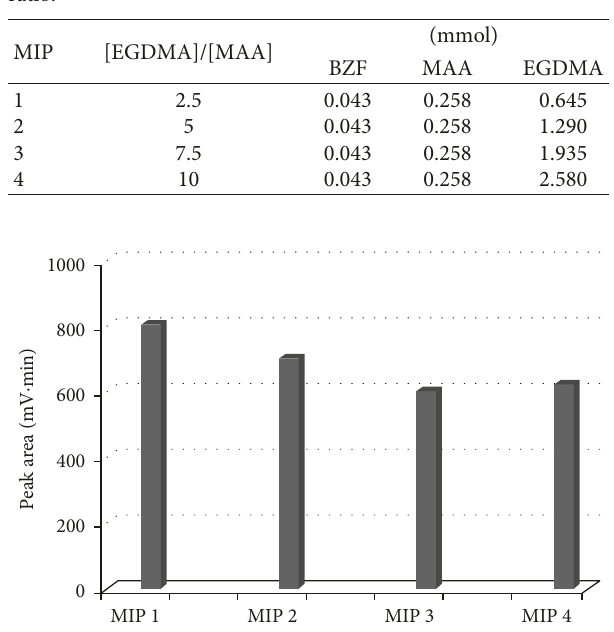
Figure 6: BZF peak area for each MIP after incubation time.